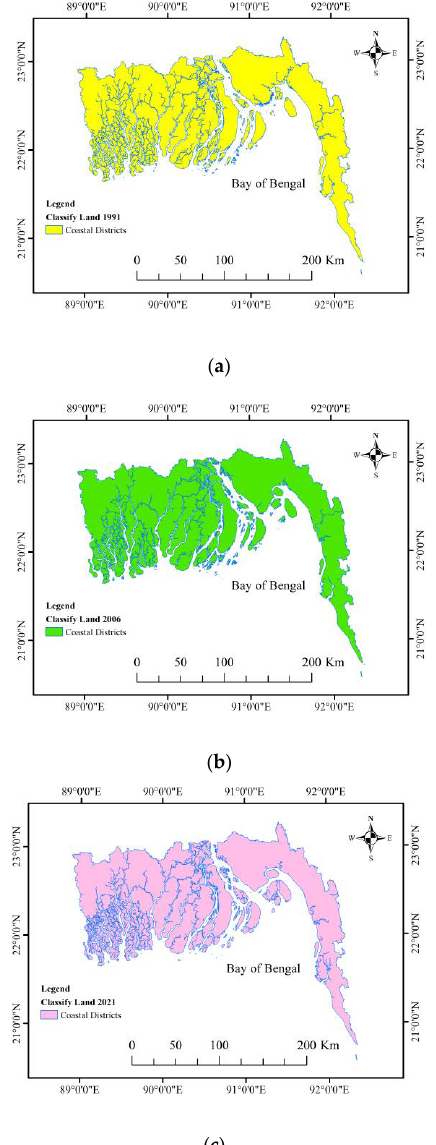
Figure 5. Reclassification of lands of coastal districts: ( a ) 1991, ( b ) 2006, and ( c ) 2021.